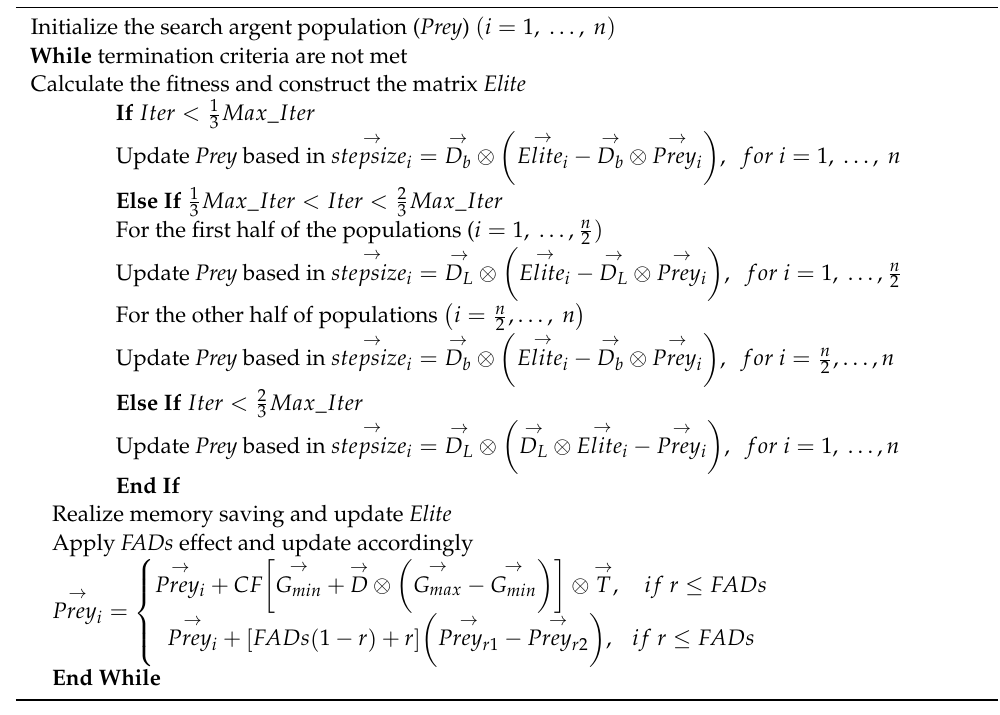
Algorithm 1. Pseudocode of applied MPA